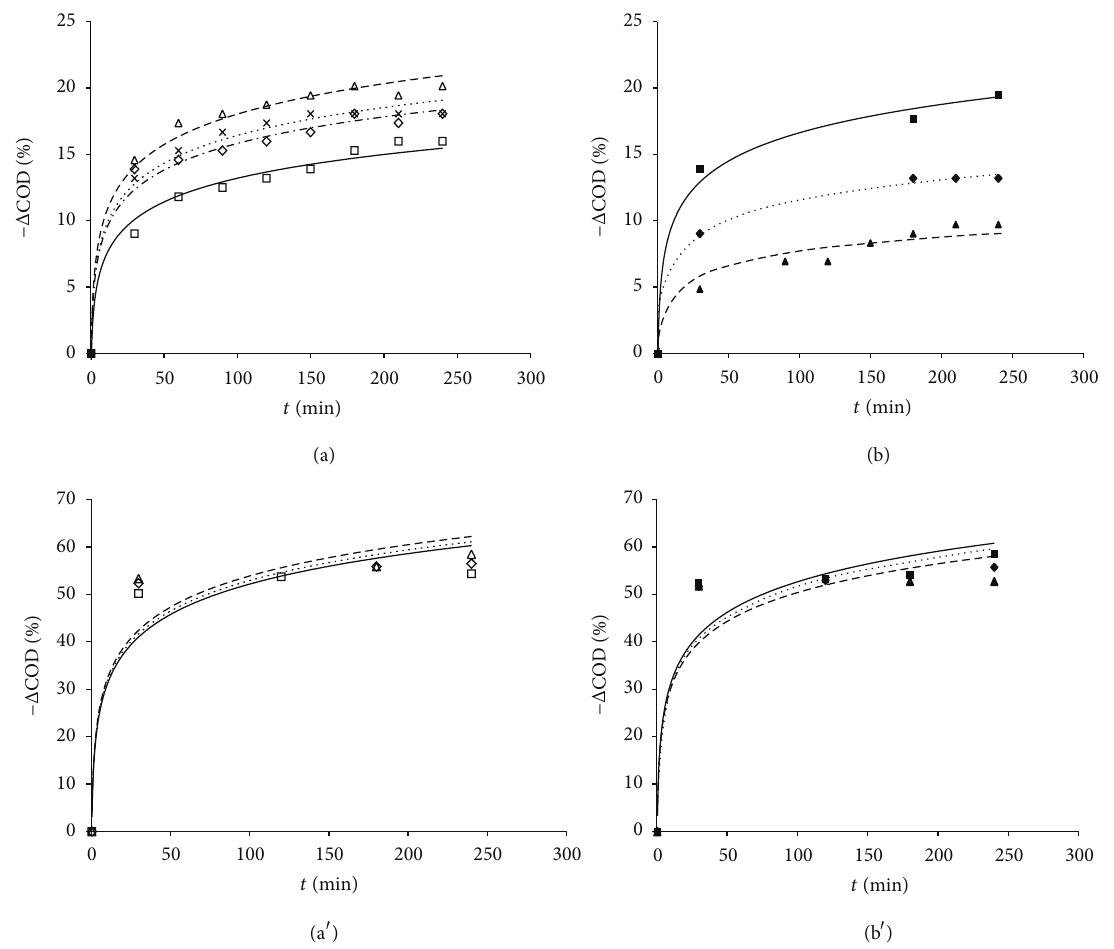
Figure 7: Results withdrawn from UV/TiO 2 photocatalysis experiments on lab scale with OMW: commercial Degussa P-25 (a): ◻ = 1g/L, ◊ = 3g/L, Δ = 9g/L, x = 20g/L; lab-made ferromagnetic-core nanopowder (b): ◼ = 1g/L, Q = 3 g/L, 󳵳 = 9 g/L; MOMW: Degussa P-25 (a 󸀠 ): ◻ = 1g/L, ◊ = 3 g/L, Δ = 9g/L; lab-made ferromagnetic-core nanopowder (b 󸀠 ): ◼ = 0.5 g/L, Q = 1g/L, 󳵳 = 3g/L.